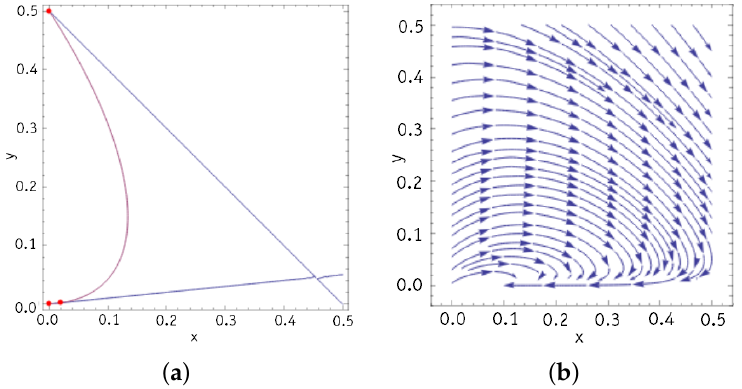
Figure 2. ( a ) Nullclines of ˙ x and ˙ y in (11) in blue, and nullcline of ˙ y in (14) in purple for parameters α = 1, β = 2, γ = 0.1, δ = 0, (cid:101) = 21/22, l = 1. The red dots show the intersection points between the nullclines. ( b ) For the same parameters some integral curves of (14), indicating the dynamics of the